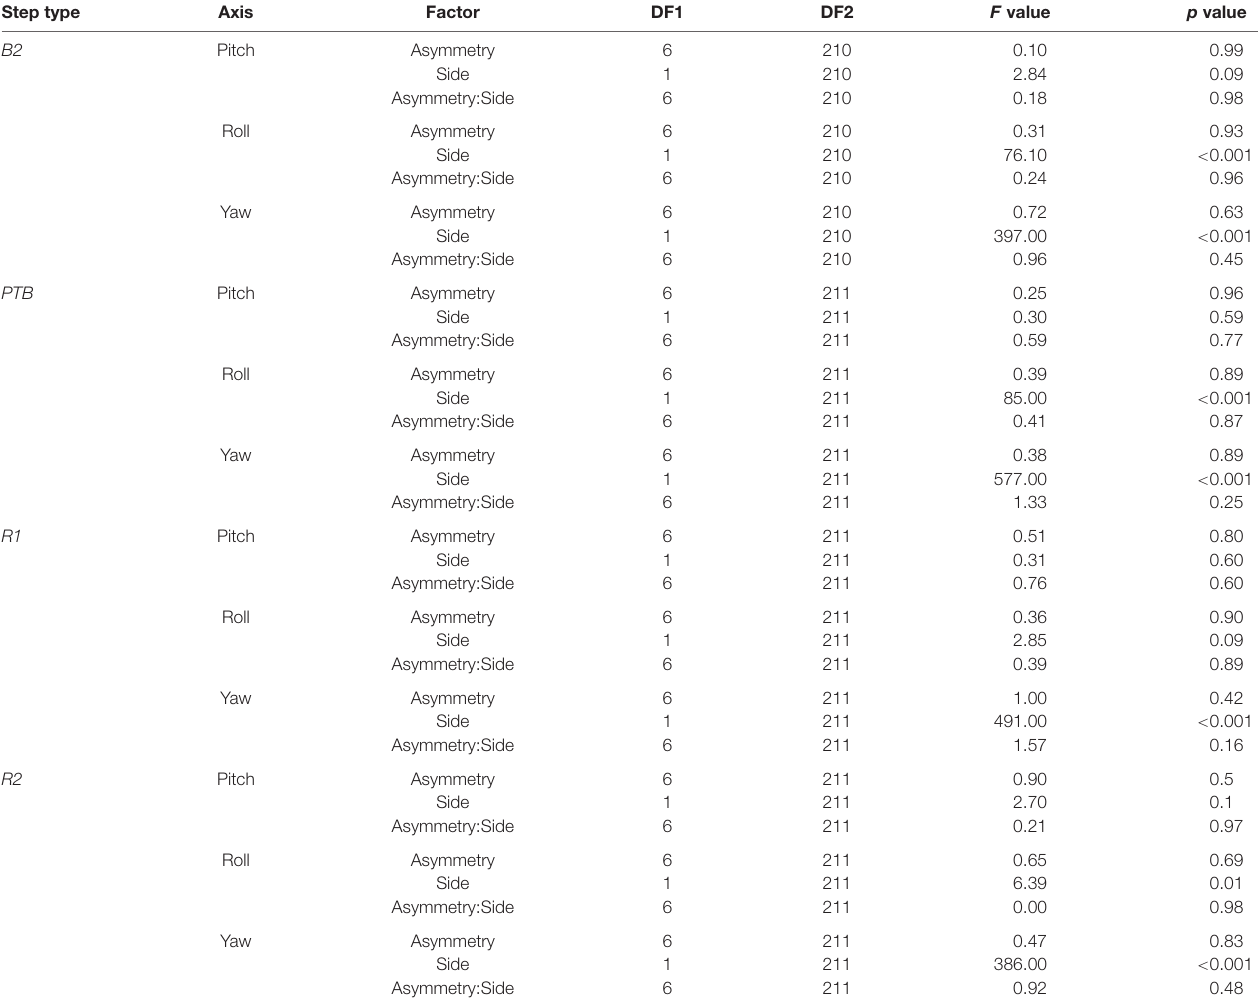
TABLE 1 | Statistical results from the ANOVA examining the effects of asymmetry and perturbation side on integrated whole-body angular momentum (WBAM) for each step type. Step